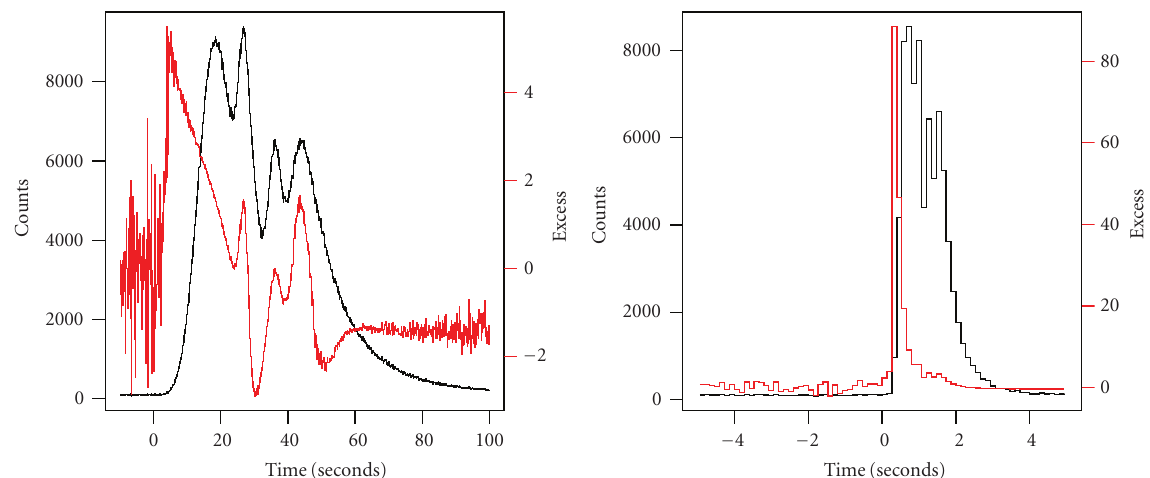
Figure 5: Response of the di ff erential imaging method to the Naked-Eye Burst, as seen by the TORTORA camera software. Left pane: original burst light curve in counts (black line), and corresponding deviations from the mean value over 100 previous points in units of the standard deviation estimated over the same interval (red line). The response is highly non-linear due to the influence of the burst itself on the estimation of the mean and standard deviation. The deviation never exceeds 5 σ . Right pane: response to a burst with the same temporal structure and brightness, but 30 times shorter than Naked-Eye Burst (2-second duration). There is a sharp ∼ 90 σ peak in deviation.